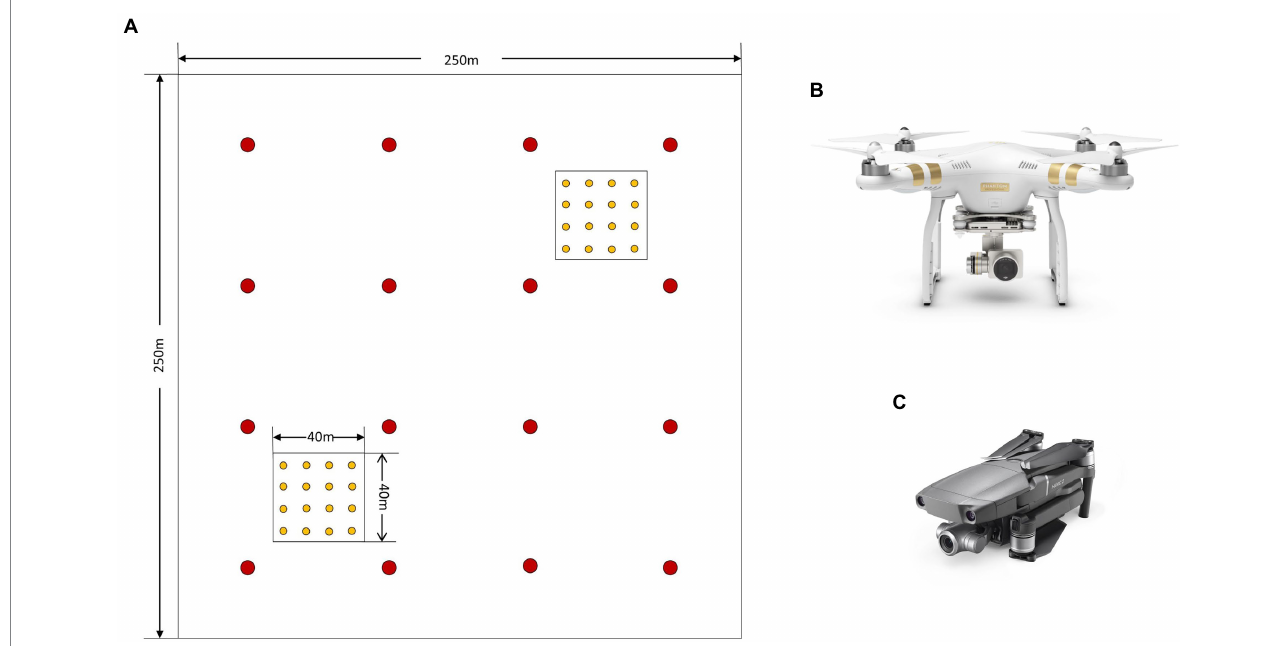
FIGURE 3 Strategy of field observation and data collection, (A) is the strategy of observation sites, (B) and (C) are Phantom 3 professional and Mavic 2 zoom Quad- Rotor intelligent UAVs.